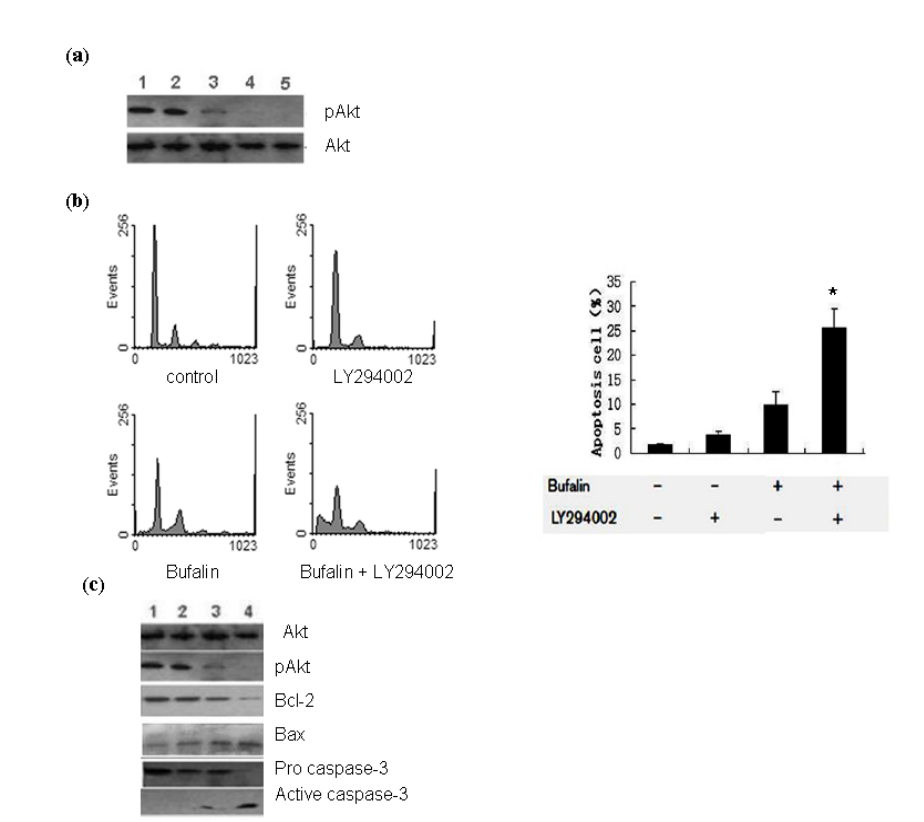
Figure 4. Bufalin modulates the activation of PI3K/Akt pathway in A549 cells. ( a ) Western blot analysis of the level of p-Akt in differently treated A549 cells. Total Akt level served as loading control. Shown are representative blots from three independent experiments with similar results: 1. 0 h; 2. 100 nmol/L bufalin for 24 h; 3. 100 nmol/L bufalin for 48 h; 4. 25 μ mol/L LY294002 for 2 h plus 100 nmol/L bufalin for 24 h; 5. 25 μ mol/L LY294002 for 2 h plus 100 nmol/L bufalin for 48 h. ( b ) A549 cells were pretreated with 25 μ mol/L LY294002 for 2 h followed by treatment with 100 nmol/L bufalin for 48 h as indicated and the apoptosis was examined by PI staining and flow cytometry analysis. Data were derived from three independent experiments. * P < 0.01 vs. left three groups of cells. ( c ) Western blot analysis of the levels of Bcl-2, Bax, livin and activated caspase-3 in differently treated A549 cells. Total Akt served as loading control. Shown are representative blots from three independent experiments with similar results: 1. 0 h; 2. 100 nmol/L bufalin for 24 h; 3. 25 μ mol/L LY294002 for 2 h; 4. 25 μ mol/L LY294002 for 2 h plus 100 nmol/L bufalin for 24 h